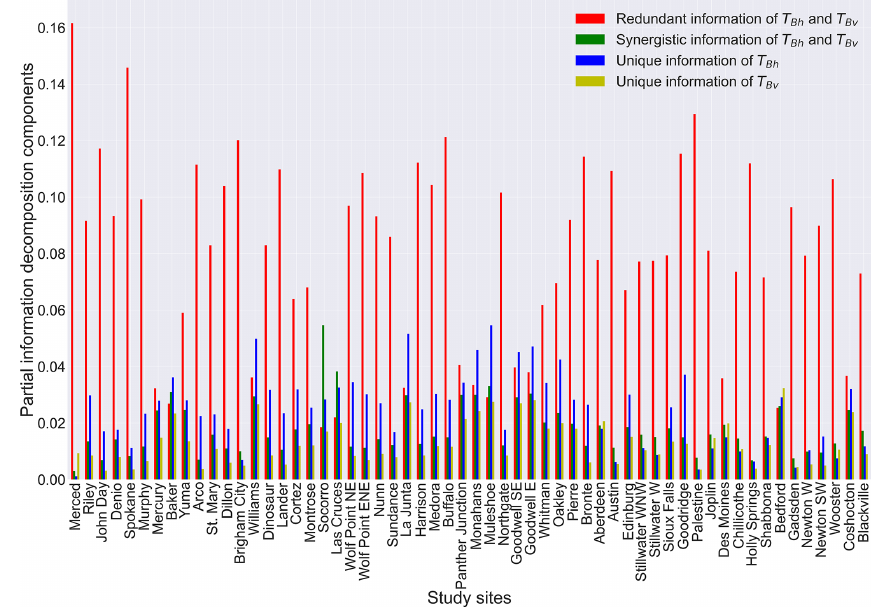
Figure 6. Partial information decomposition components between horizontally ( T Bh ) and vertically ( T Bv ) polarized brightness temperature and DCA soil moisture. See Fig. 2 caption for site